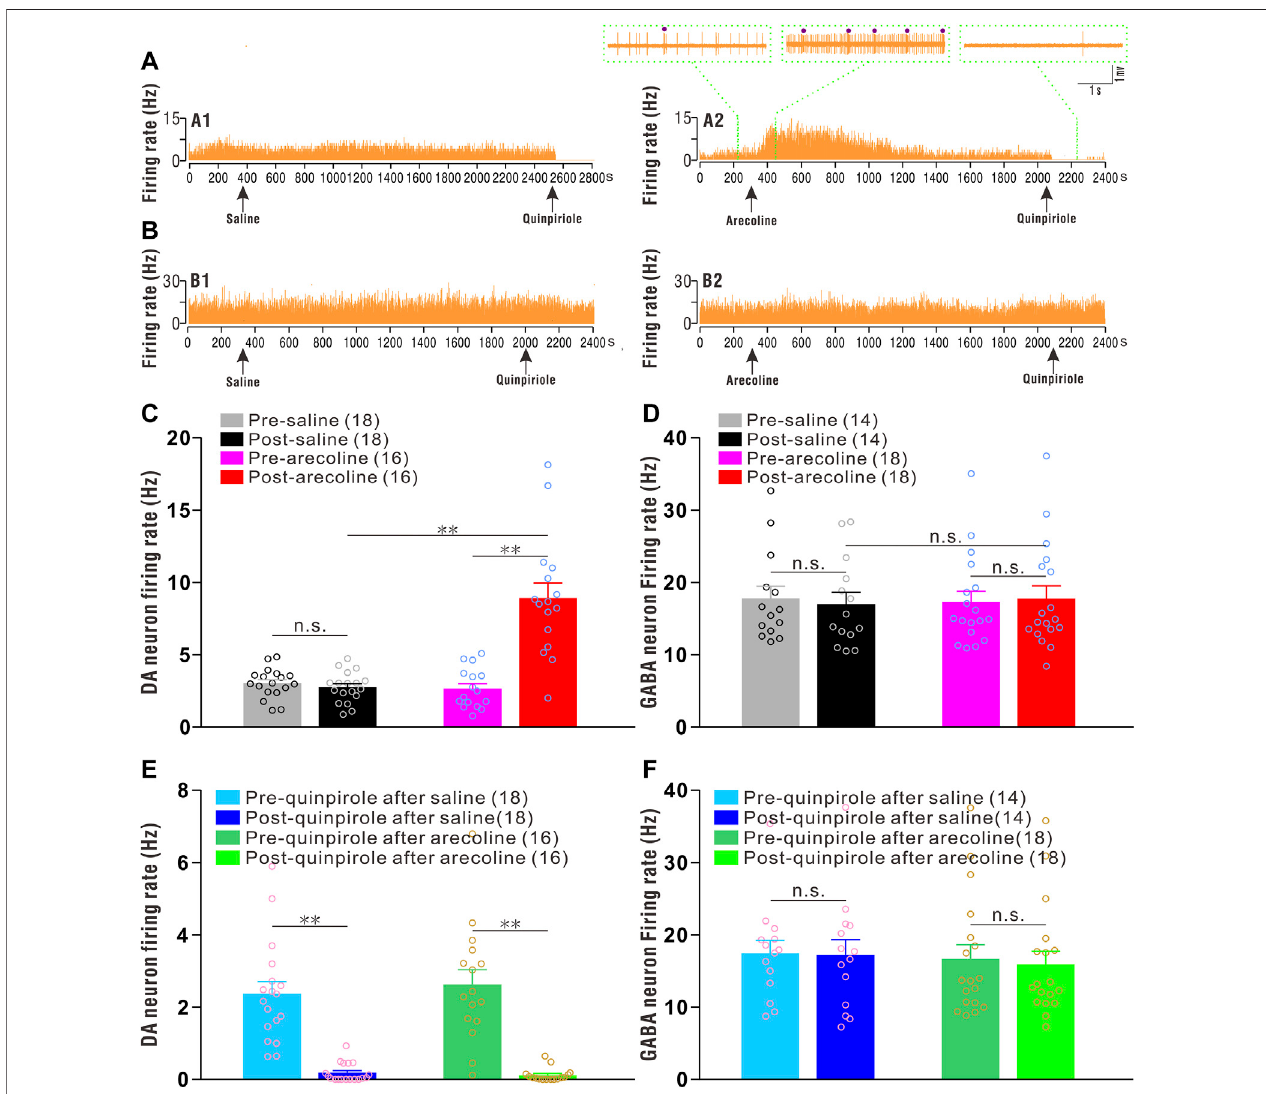
FIGURE 1 | Arecoline increases the fi ring rates of VTA dopaminergic neurons. (A) Representative recordings from a dopaminergic neuron before and after saline (A1) and arecoline (A2) treatment, and then with quinpirole administration. (B) Representative recordings from a GABAergic neuron before and after saline (B1) and arecoline (B2) treatment, and then with quinpirole administration. The arrowheads indicate the time of injections. The left and middle insets (above A2) represent the tracesofdopaminergicneuron fi ringsbeforeandafterarecolineadministration,andtherightinset(aboveA2)representsthe fi ringresponsetoquinpirole.Thesmall dots indicate putative bursts. (C,D) Histograms of the fi ring rates of dopaminergic neurons (C) and GABAergic neurons (D) before and after saline/arecoline injections. (E,F) Histograms of the fi ring rates of dopaminergic neurons (E) and GABAergic neurons (F) before and after quinpirole injections. The numbers presented in the parentheses denote the number of neurons measured, while the overlaid dots are the individual data points. DA neuron: dopaminergic neuron. ** p < 0.01; NS, not signi fi cant.